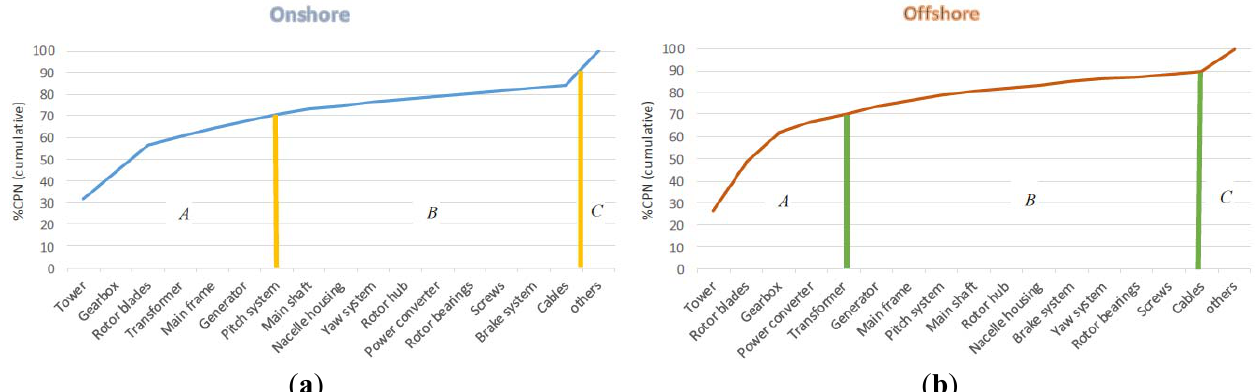
Figure 8. Cumulative %CPNs for the sixteen sub-assemblies of ( a ) onshore ( b ) offshore wind turbine